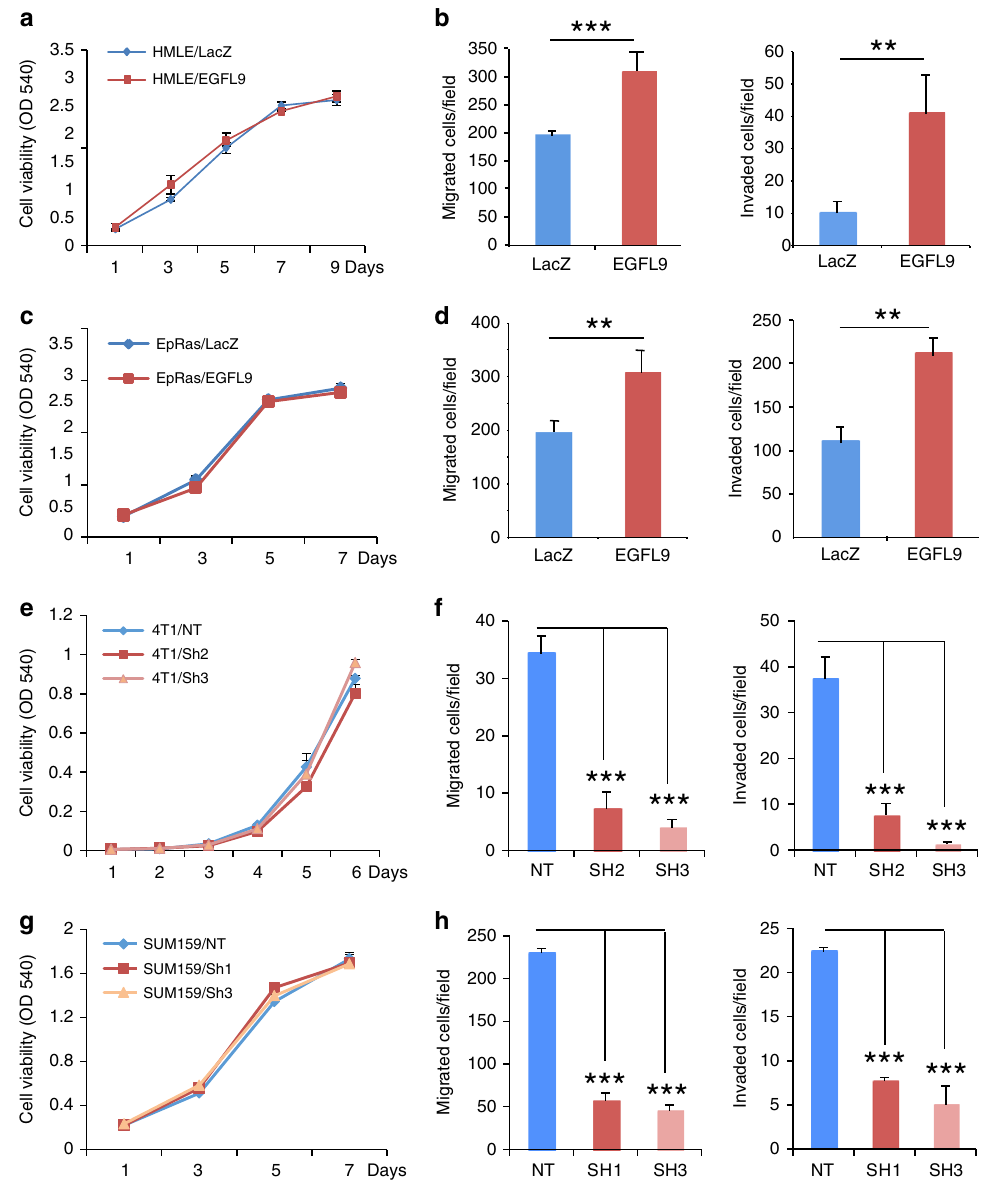
Fig. 2 The effect of EGFL9 on cell motility in vitro. a The ectopic expression of EGFL9 does not change cell proliferation in the HMLE cell line. Cell proliferation was measured by MTT assay over 9 days. b The ectopic expression of EGFL9 increased cell migration (left panel, *** P < 0.001) and invasion (right panel, ** P < 0.01) in HMLE cells. c The ectopic expression of EGFL9 does not change cell proliferation in the EpRas cell model. Cell proliferation was measured by MTT assay over 7 days. d The ectopic expression of EGFL9 increased cell migration (left panel, ** P < 0.01) and invasion (right panel, ** P < 0.01) in EpRas cells. e Knockdown of EGFL9 expression does not affect the cell proliferation in 4T1 cells. Cell proliferation was measured by MTT assay over 6 days. f Knockdown of EGFL9 expression signi fi cantly decreased migration (left panel, shRNA2/non-target control = 21% and shRNA3/non-target control = 12%, *** P < 0.001) and invasion (right panel, shRNA2/non-target control = 19% and shRNA3/non-target control = 5.5%, *** P < 0.001) in 4T1 cells. g Knockdown of EGFL9 expression does not affect proliferation of SUM159 cells. Cell proliferation was measured by MTT assay over 7 days. h Knockdown of EGFL9 expression decreased migration (left panel, shRNA1/non-target control = 22.2% and shRNA3/non-target control = 21%, *** P < 0.001) and invasion ability (right panel, shRNA1/non-target control = 32% and shRNA3/non-target control = 16%, *** P < 0.001) in SUM159 cells. All experiments were performed in triplicate. The data number was the mean value from fi ve randomly selected fi eld views. Each bar represents the mean ± SEM (standard error of the mean). P values were determined by unpaired two-tailed t